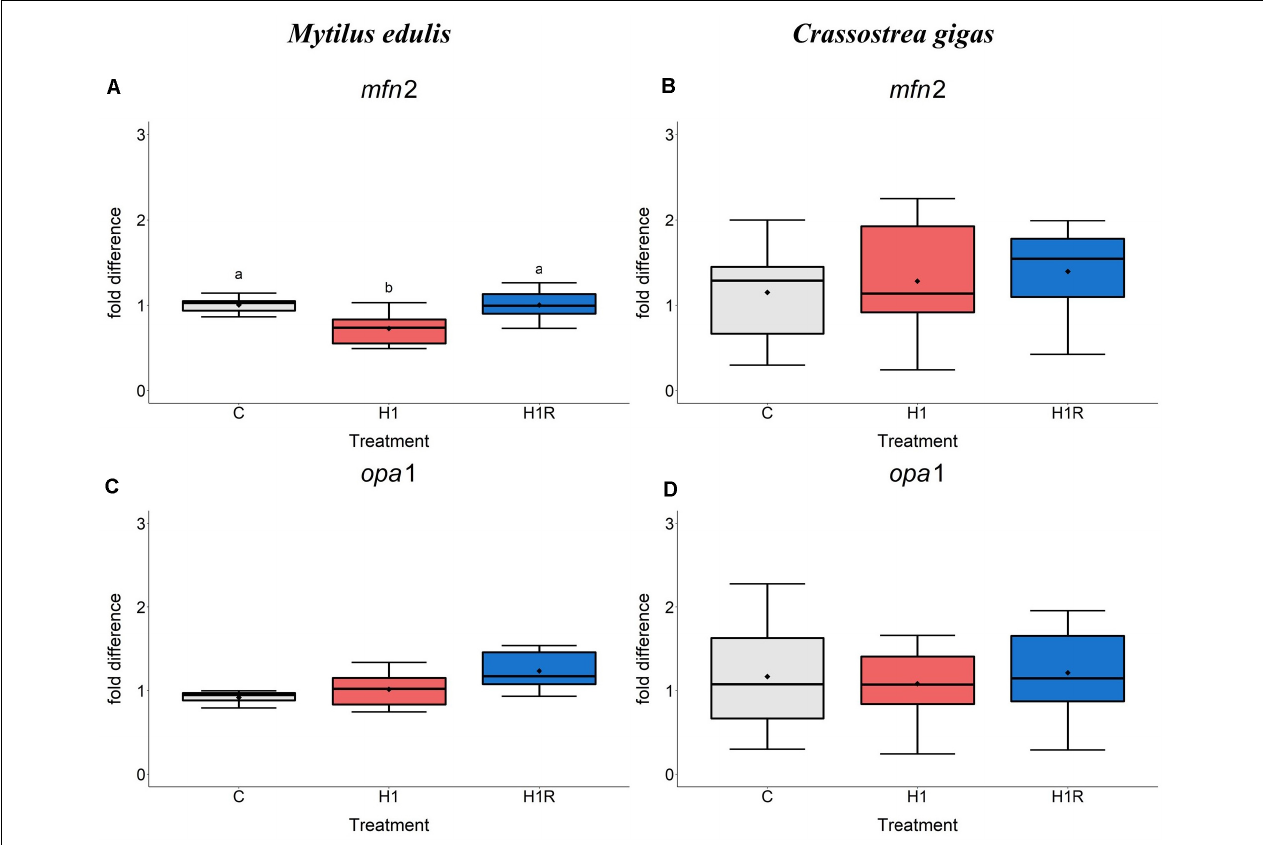
FIGURE 1 | mRNA expression of mitochondrial fusion proteins in M. edulis and C. gigas hepatopancreas in response to H/R stress. (A,C) M. edulis ; (B,D) C. gigas ; (A,B) mfn 1 mRNA; (C,D) opa 1 mRNA. Experimental groups: C, control; H1, short-term (1 day) severe hypoxia; H1R, short-term (1 day) severe hypoxia and subsequent 1.5 h reoxygenation. Means are depicted as points within corresponding Box-Whisker-plot. Outliers are shown as asterisk (*). Different letters above plots represent values that are statistical significantly different from each other ( p < 0.05). Plots sharing a letter are not significantly different ( p > 0.05). N =